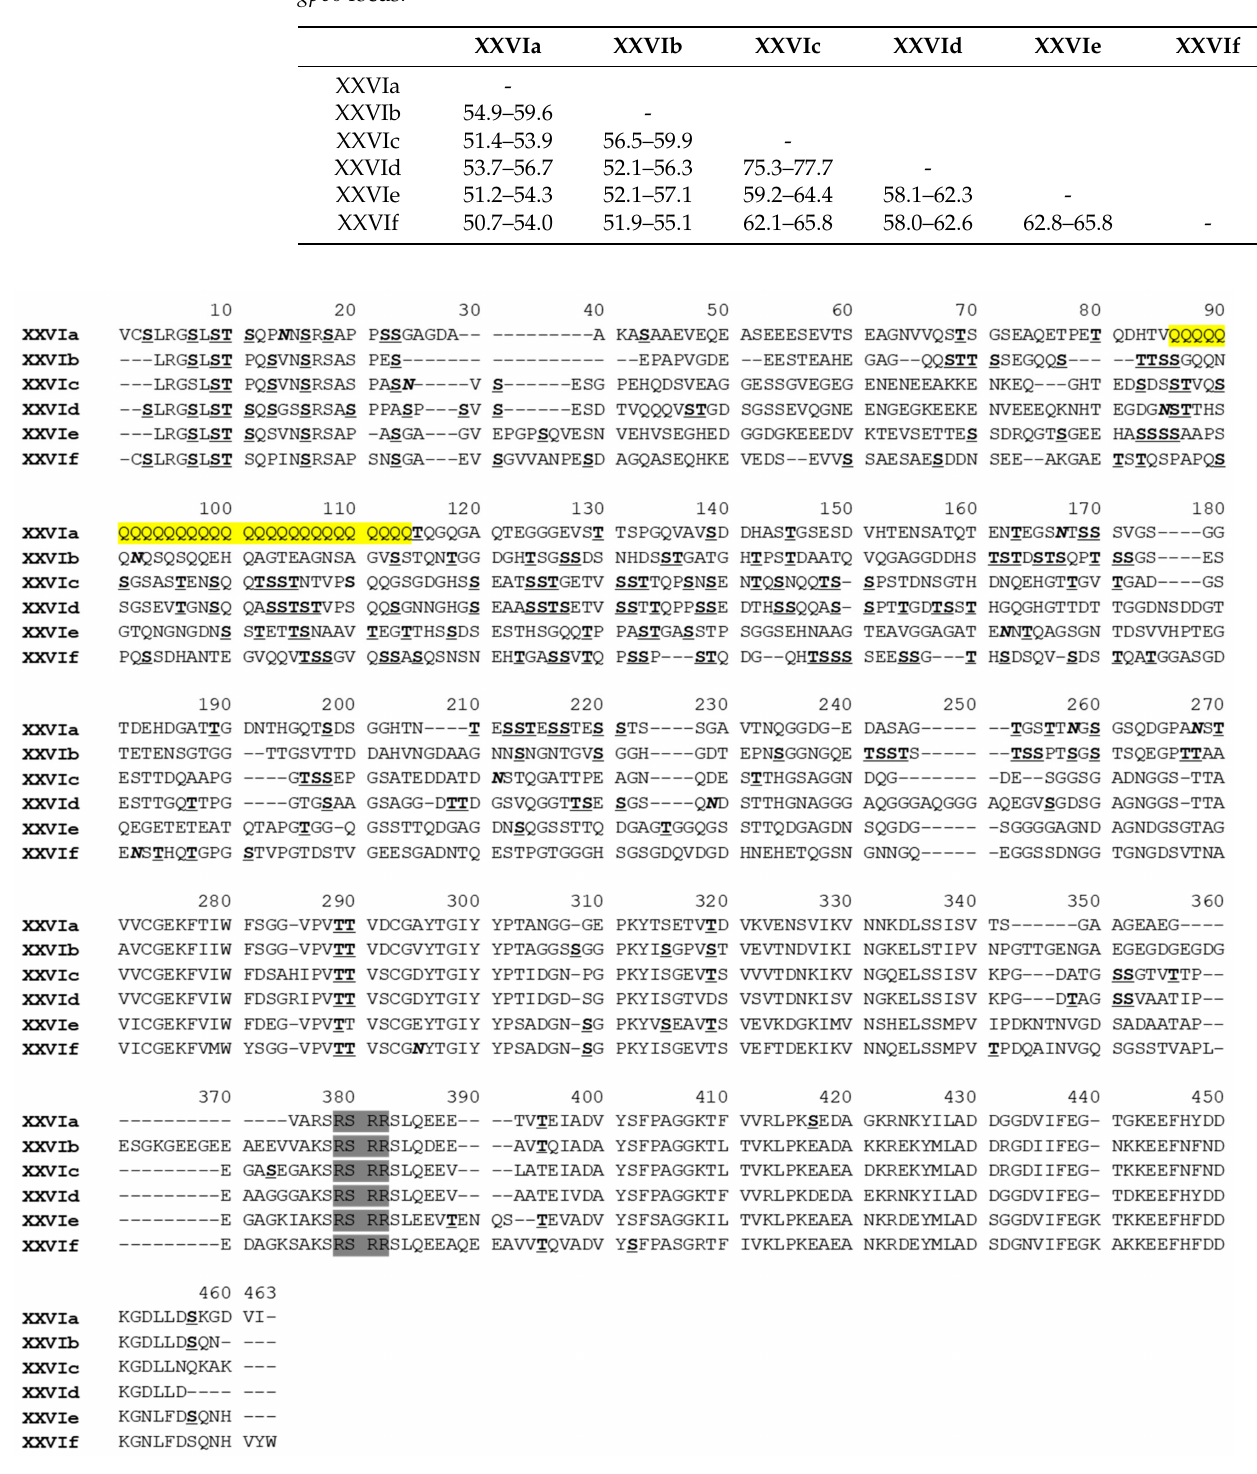
Table 2. Percent nucleotide sequence identity among Cryptosporidium bovis subtype families at the